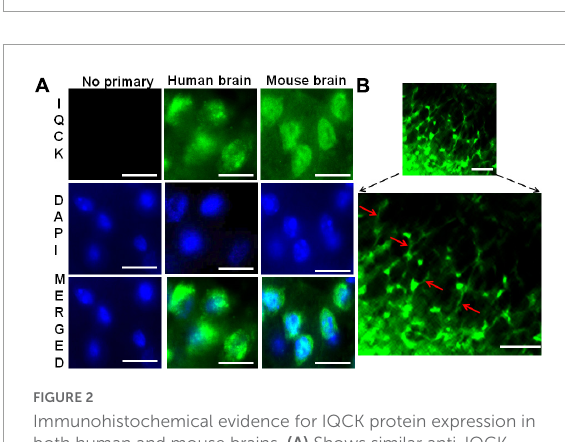
FIGURE1 IQCK immunoreactivity is positive in SH-SY5Y and HeLa cells but negative in HMC3 microglial cells and CHO cells. Representative images are shown for different cell types with IQCK-immunoreactive (red) and DAPI-stained nuclei (blue). Merged images indicate IQCK expression in both the cytoplasm and nuclei. Scale bars indicate 20 µ m.